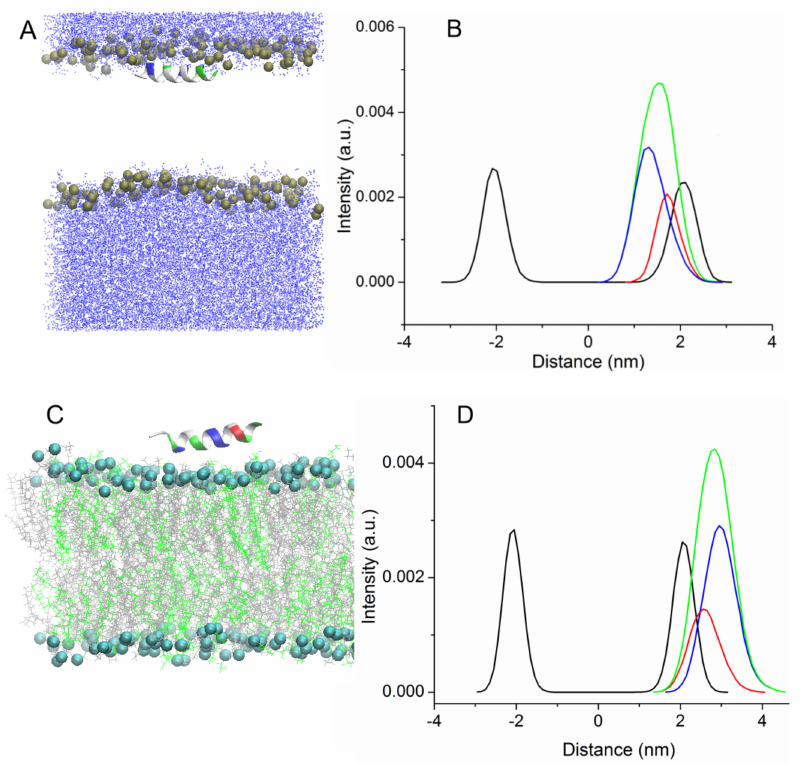
Figure 2. Snapshots of the systems for the simulations Tr1 ( A ) and Tr3 ( C ). Peptide is shown in the cartoons and is colored according to residue types. Density profiles ( B , D ) along the bilayer normal are plotted for the phosphate group (black), peptides (green), hydrophilic residues (red), and hydrophobic residues (blue). In Figure 2A, lipids are hidden for clarity. In Figure 2C, water molecules are not